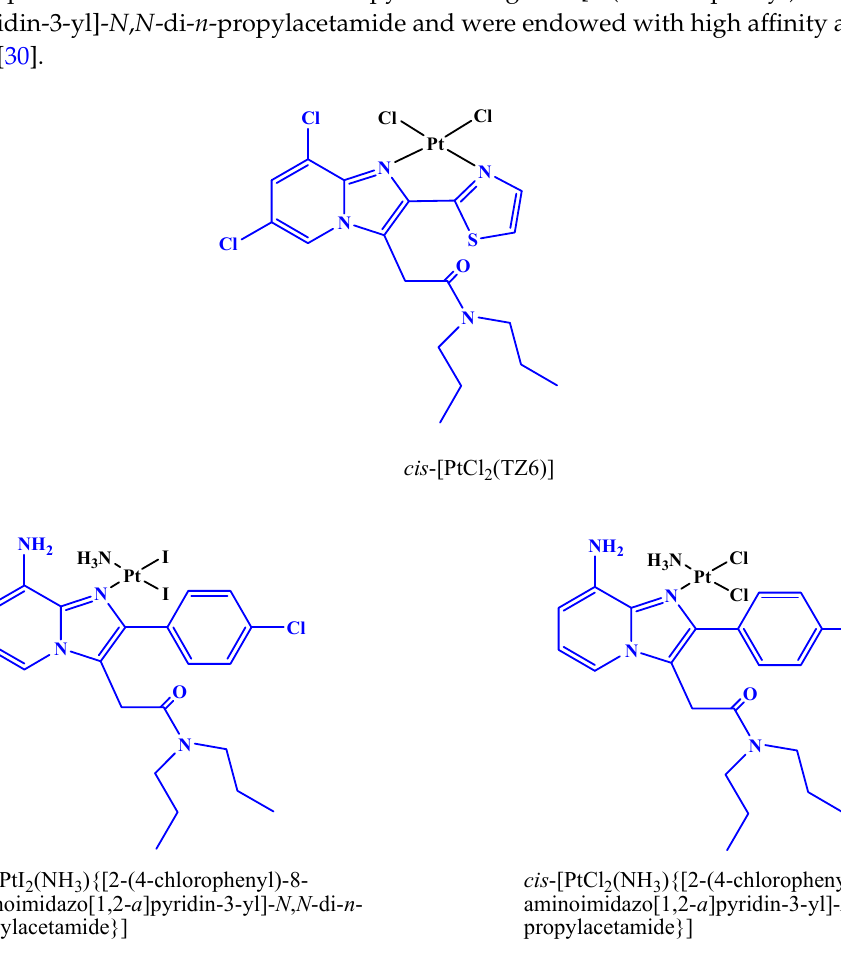
Figure 2. Pt(II) complexes with TSPO ligands (highlighted with a blue color).